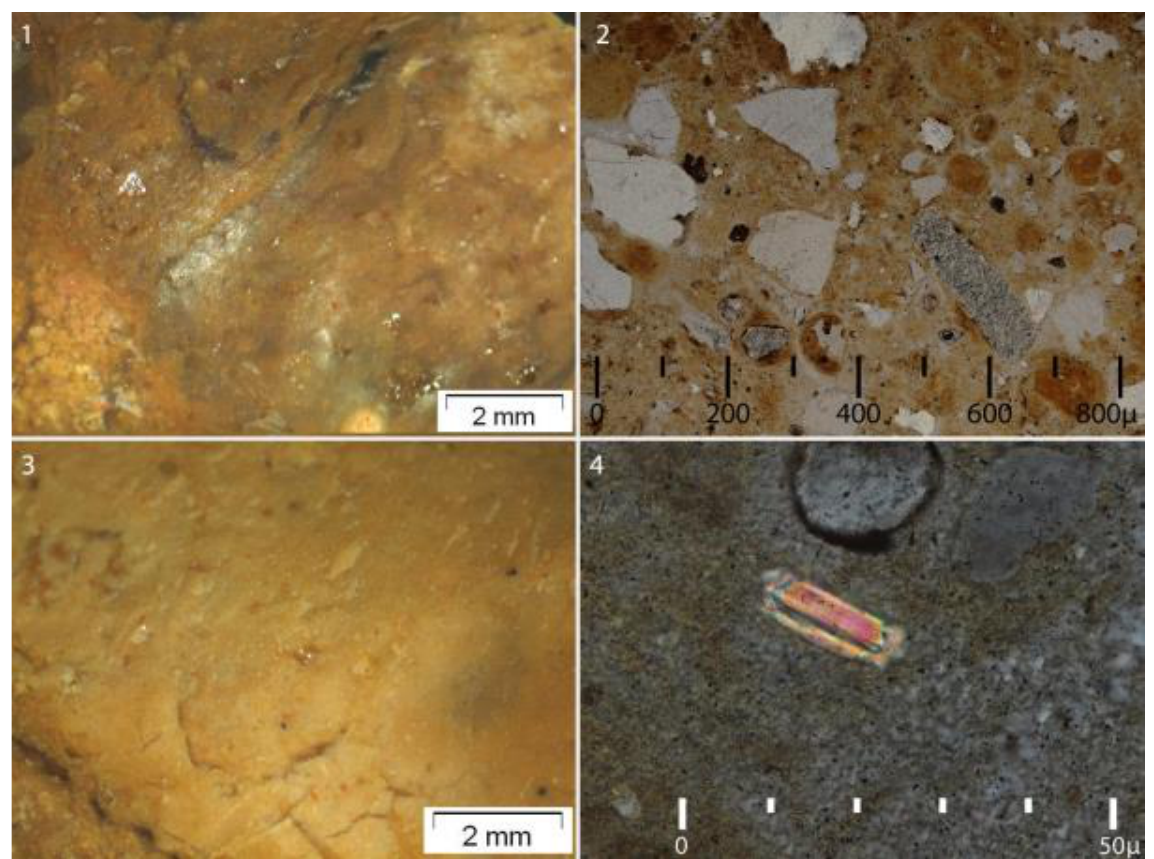
Figure 9. Macro- and microscopic textures and constituents of Cenozoic silcretes. Note the brecciated structure (1-3) and detrital materials (2,